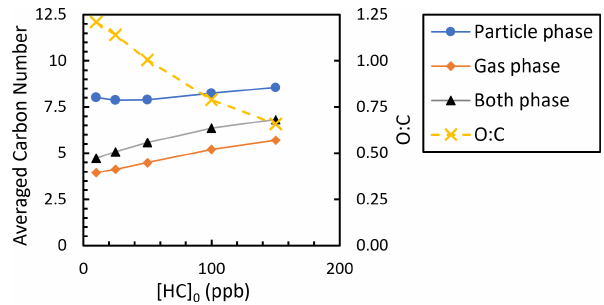
Figure 10. GECKO-A-predicted particle O:C and mole-weighted average carbon number of products with added NO x